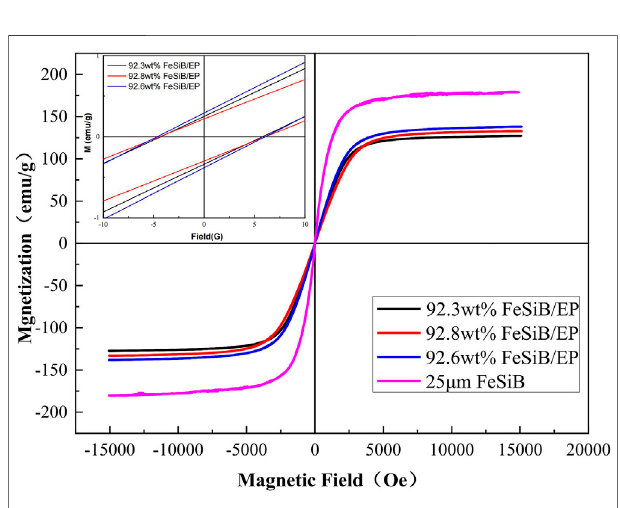
FIGURE 4 | Hysteresis circuit diagram of FeSiB/EP printed